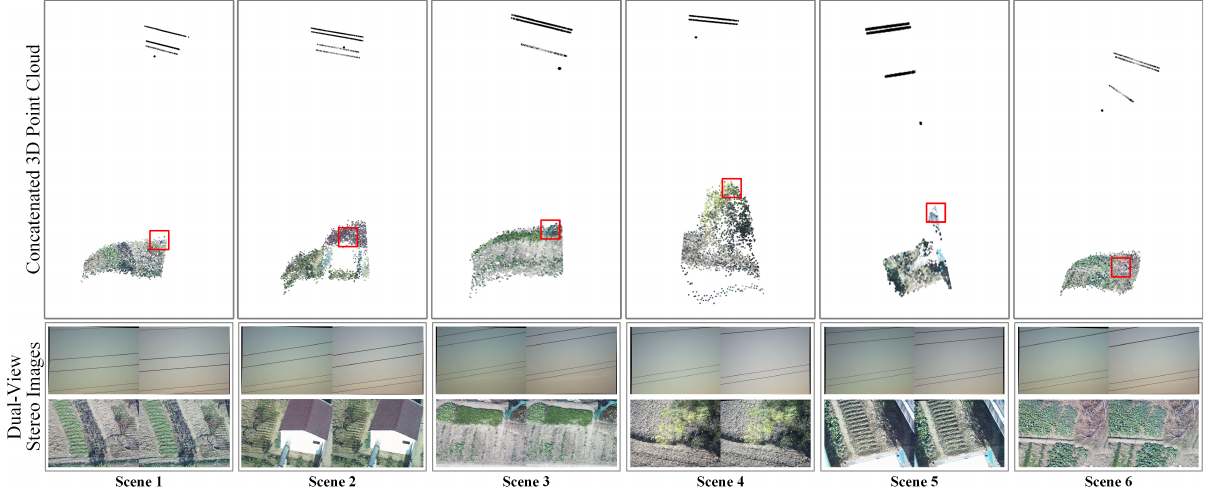
Figure 17. 3D reconstruction results of the inspection scenes.